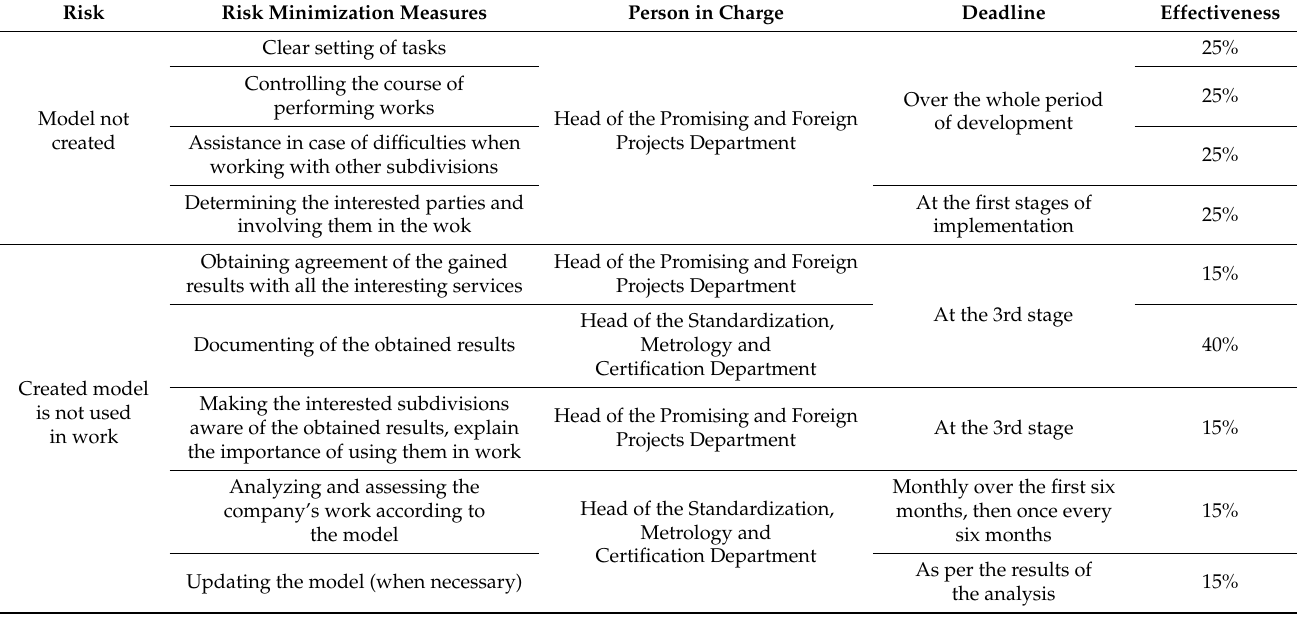
Figure 6. Cause-and-effect analysis for event No. 10. Table 7. Planned measures on the risk treatment for the process of “Developing a Model of Rolling Mill Loading with Orders with Overlapping Stock” with their effectiveness